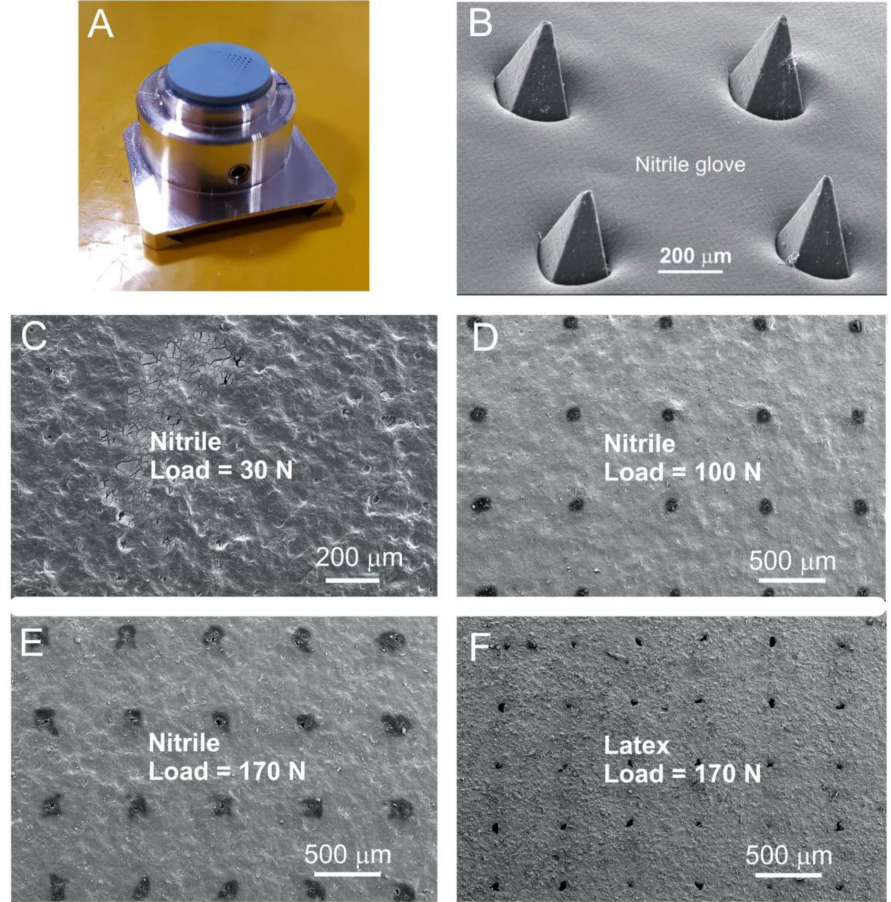
Figure 5. Penetration of 400 × 400 × 800 micron polystyrene MNs through conventional nitrile ( A – E ) or latex ( F ) gloves (100 µ m thick section). ( A ) SEM stub used for unregulated force puncture and ( B ) the corresponding micrograph. ( C – F ) Influence of compression loading post-puncture micrographs of the glove